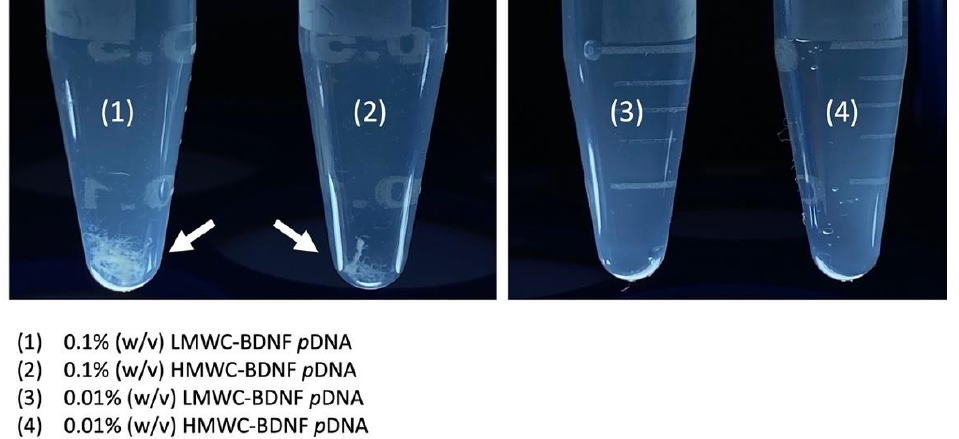
Figure 1. Gross examination of the products formed by the complexation of 0.1% ( w / v ) and 0.01% ( w / v ) of LMWC and HMWC and BDNF p DNA. Fibrillar precipitates (white arrows) were seen when 0.1% ( w / v ) of chitosan was used regardless of the molecular weight. No precipitates were observed with the 0.01% ( w / v ) chitosan.